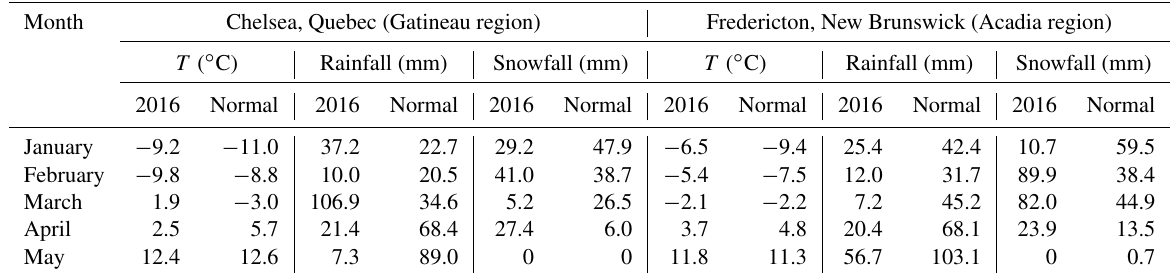
Table 1. Monthly climate data representative of study sites. Normals correspond to 1981 to 2010. Month Chelsea, Quebec (Gatineau region) Fredericton, New Brunswick (Acadia region) T ( ◦ C) Rainfall (mm) Snowfall (mm) T ( ◦ C) Rainfall (mm) Snowfall (mm) 2016 Normal 2016 Normal 2016 Normal 2016 Normal 2016 Normal 2016 Normal